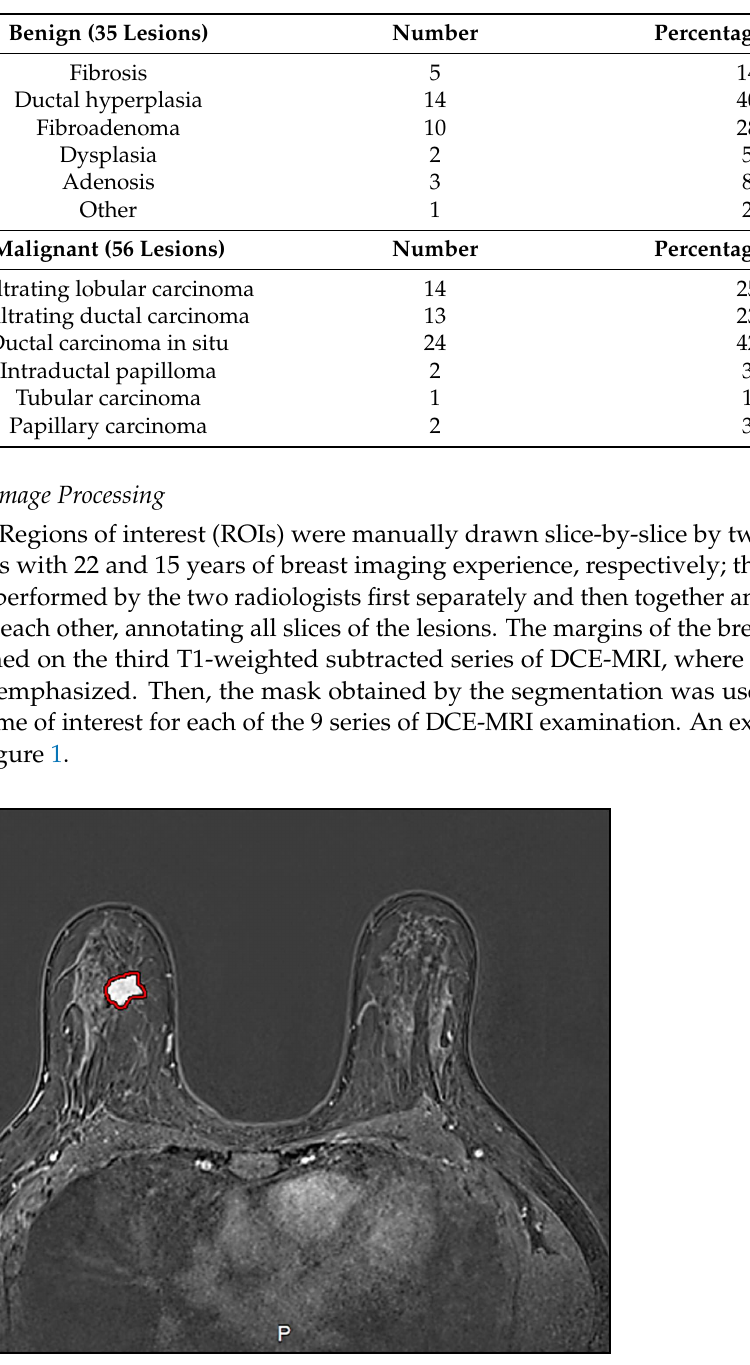
Table 2. Number and corresponding percentage of the total benign or malignant breast lesions.